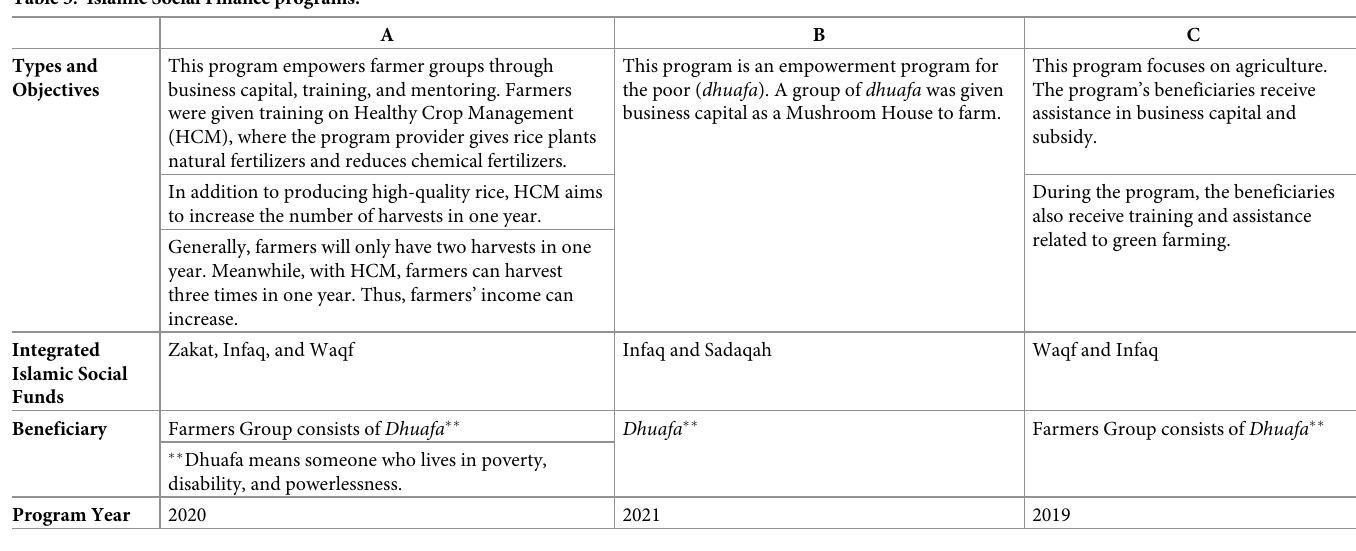
Table 5. Islamic Social Finance